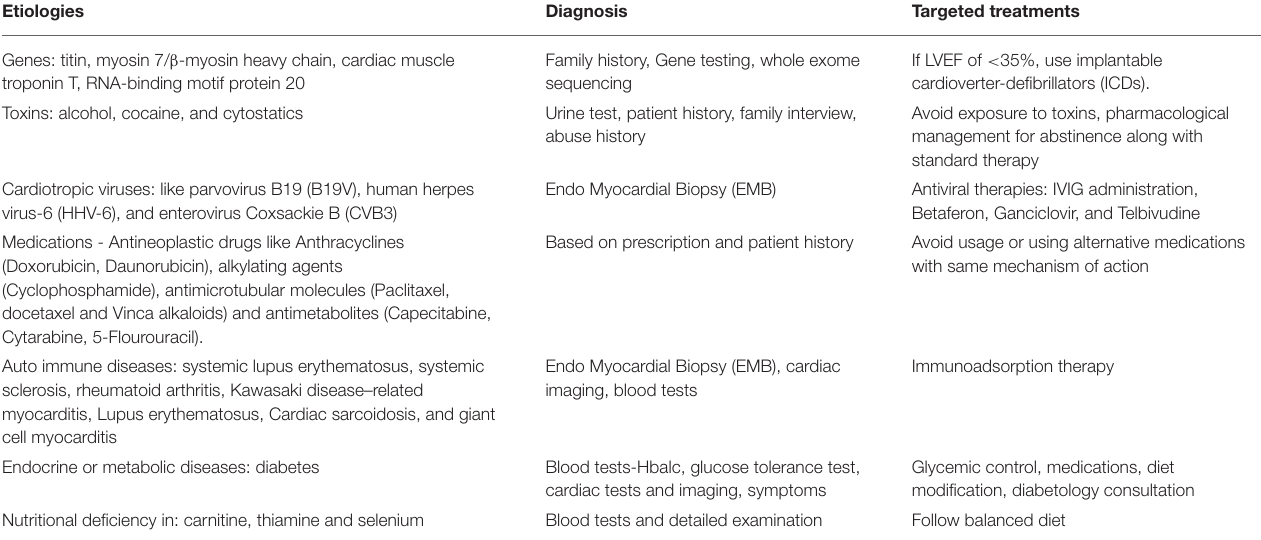
TABLE 1 | Etiologies, diagnosis, and targeted treatments for DCM. Etiologies Diagnosis Targeted